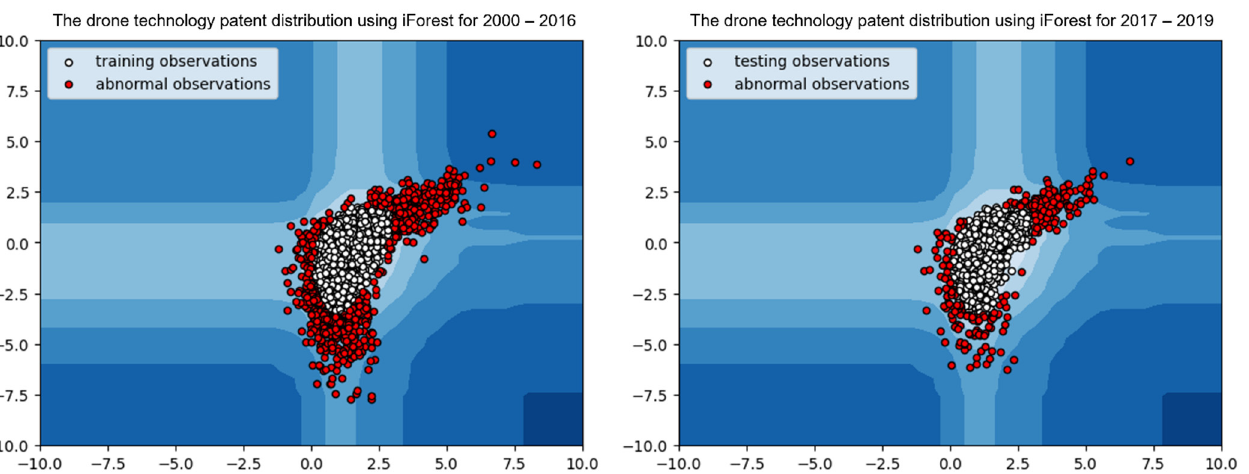
Table 7. Result of Ensemble Outlier Detection.